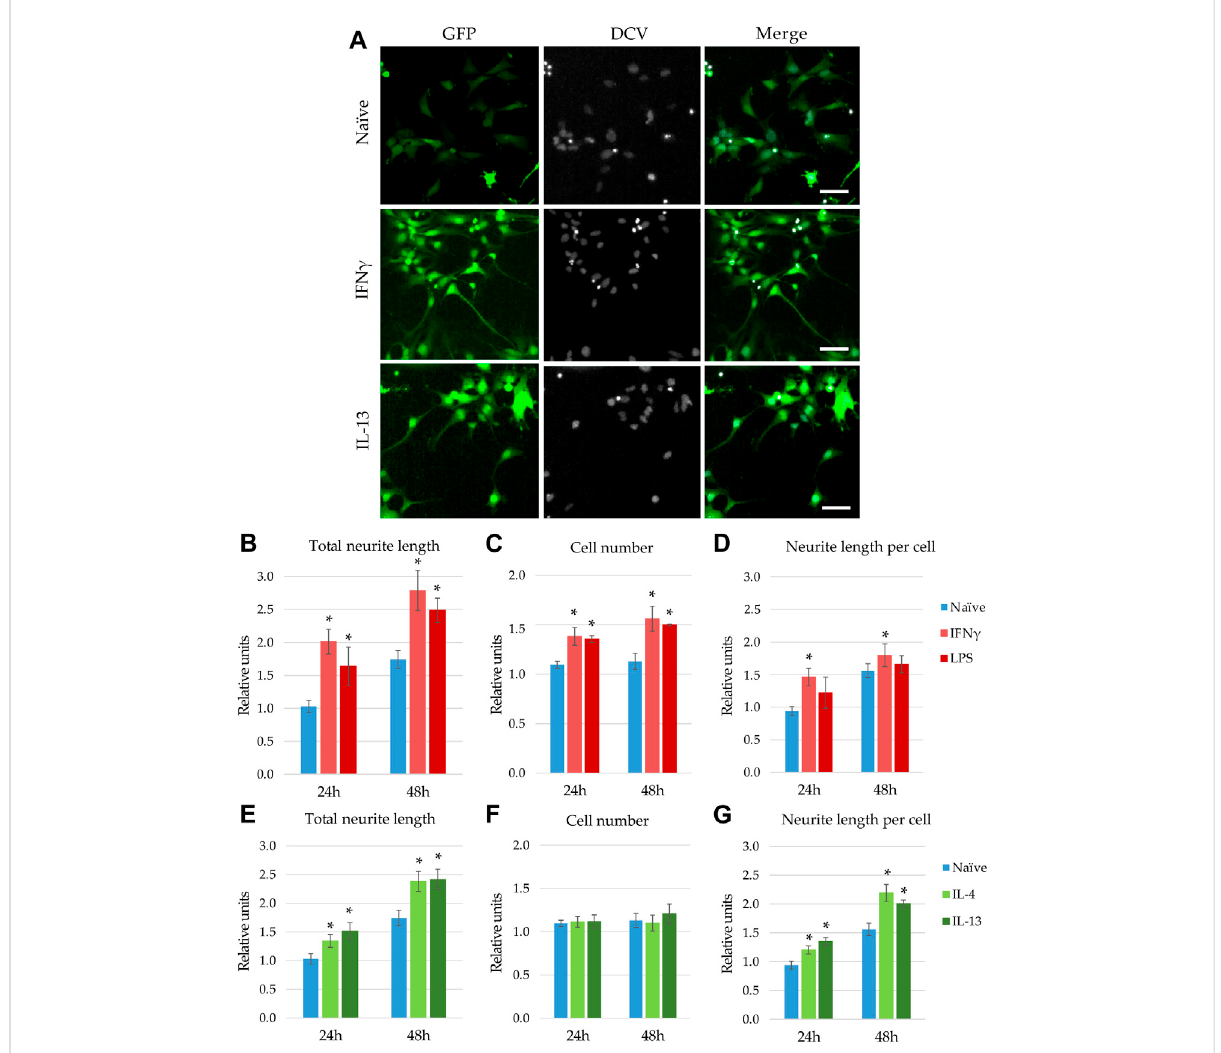
FIGURE 3 Modulatory effect of microglia stimulation on microglia-NPC interaction. GFP-NPCs were subjected to supernatants from BV2 cells previously stimulated with proin fl ammatory agents (IFN γ or LPS), or anti-in fl ammatory cytokines (IL-4 or IL-13). As controls, GFP-NPCs treated with supernatants from naïve BV2 cells were used. (A) Representative fl uorescence images depict GFP fl uorescence (green) and DCV counterstaining (grey) in GFP-NPCs exposed to naïve, IFN γ -, or IL-13-pretreated BV2 supernatants for 48 h. Scale bars: 25 µm. The total neurite lengths (B,E) , the cell numbers (C,F) , and the neurite lengths per cell (D,G) were determined at the indicated time points. The relative units represent the values normalized to time 0 points of untreated NPCs. Data are presented as mean ± SEM ( n = 4 – 7). For statistical analysis, two-way ANOVA followed